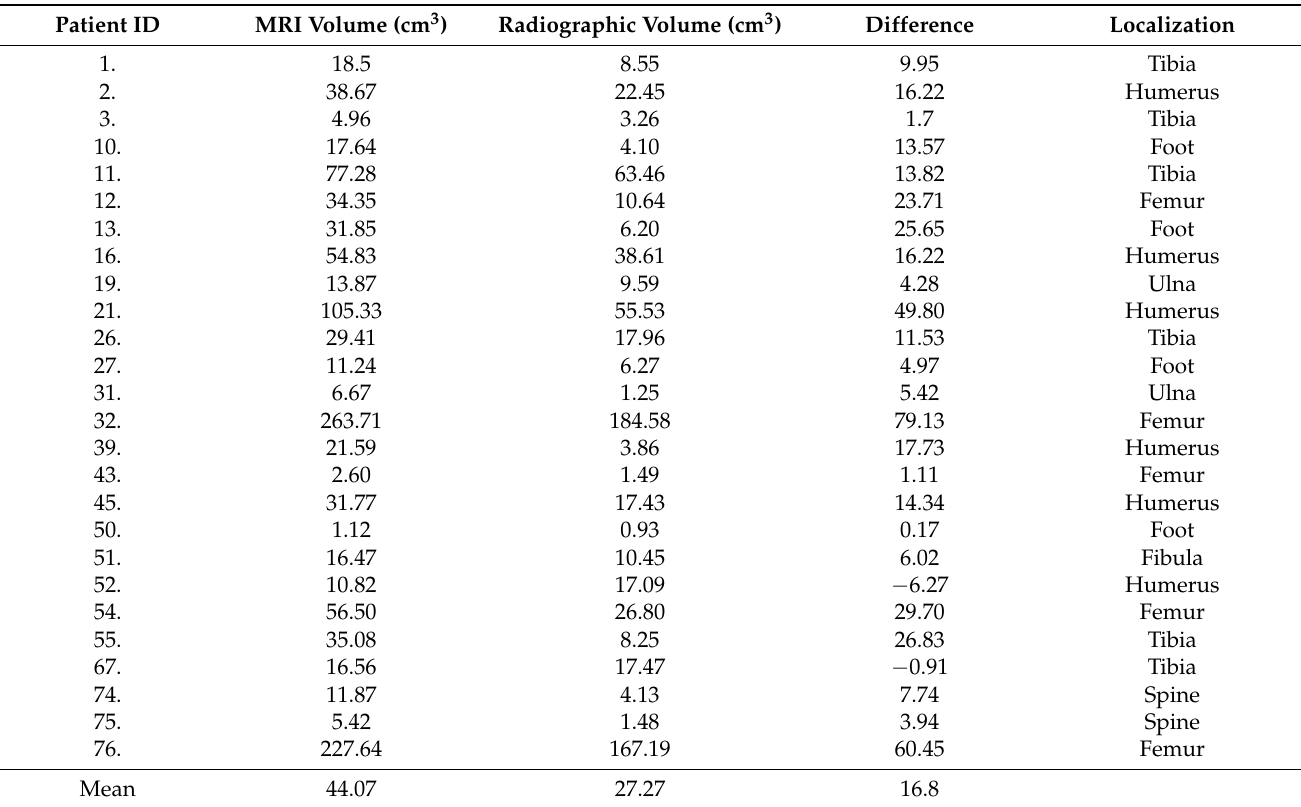
Table 4. Comparison of patients’ cyst volumes in MRI scans, conventional radiographs and the